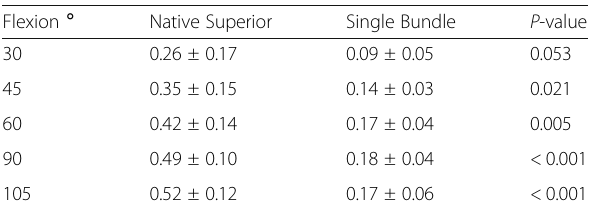
Table 2 Native superior vs Single bundle strain measurements ( n =